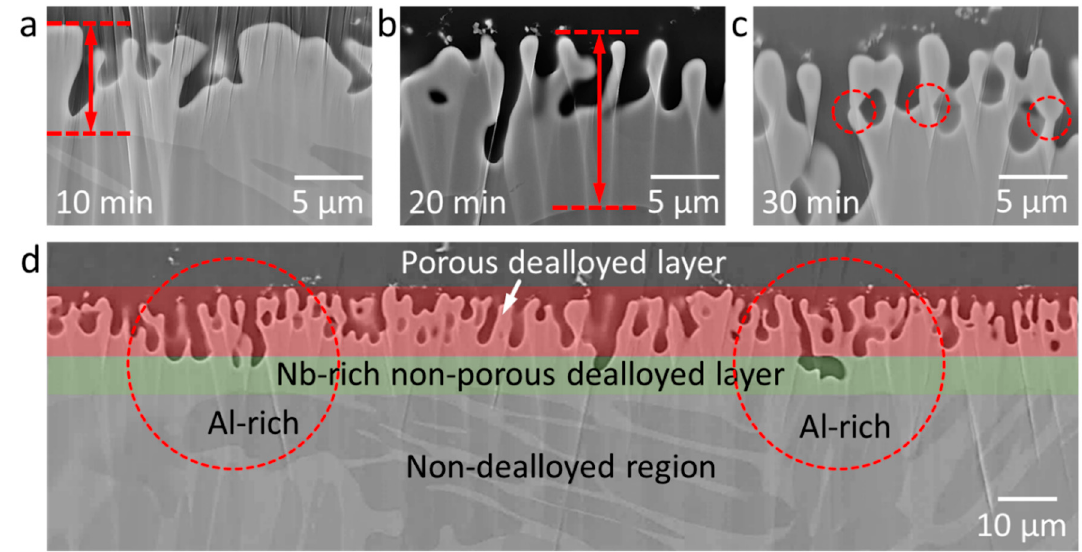
Figure 3. Scanning electron micrographs of the ion-milled cross section of Ti-6Al-7Nb dealloyed in liquid Mg at 1150 K for di ff erent times: ( a ) 10 min, ( b ) 20 min, and ( c , d ) 30 min. Note: The arrows in ( a , b ) indicate the thickness of the dealloyed layer. The dashed circles in ( c ) indicate joining of ligaments possessing a sintered-like neck morphology. The dashed circles in ( d ) indicate areas above the Al-rich phase regions possessing deeper pore depth compared to neighboring ones.